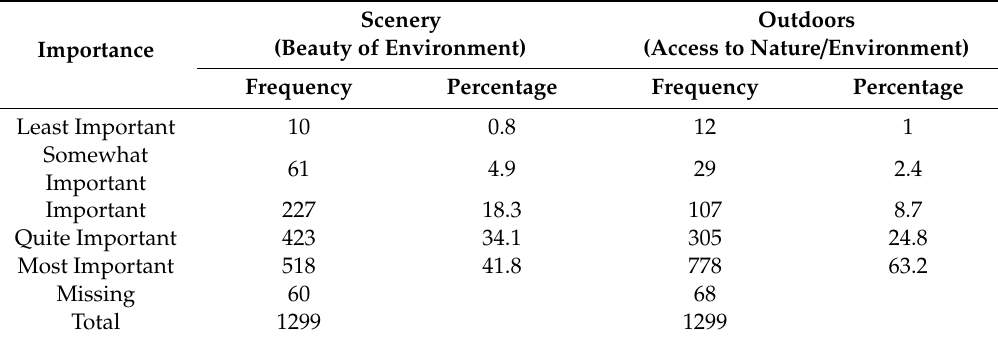
Table 5. Reasons for trail use instead of other facilities.